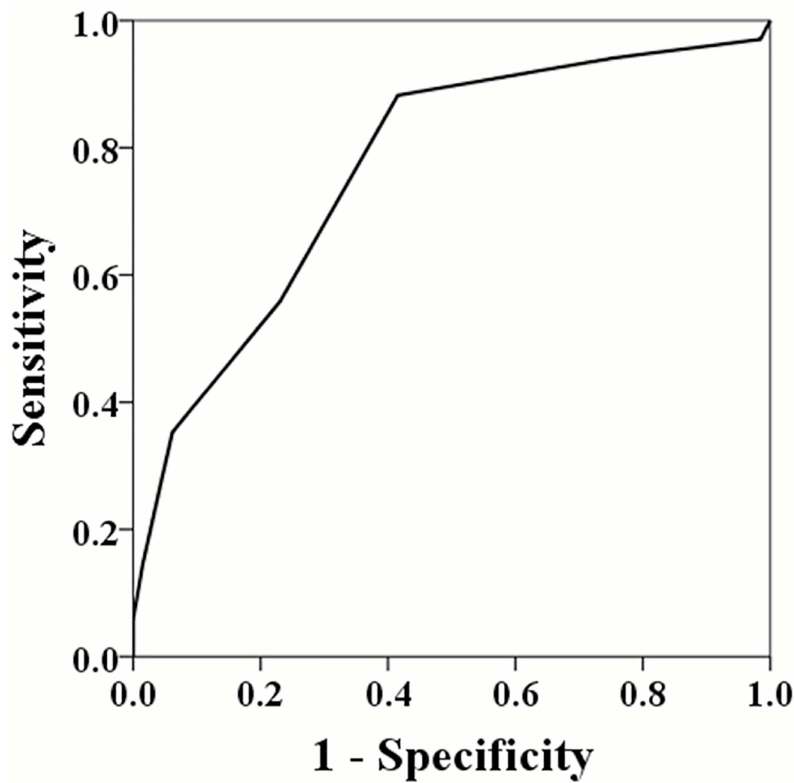
Fig 2. Receiveroperating characteristic curve for Surgical Apgar Score as a predictor of major complications (area under the curve = 0.768).